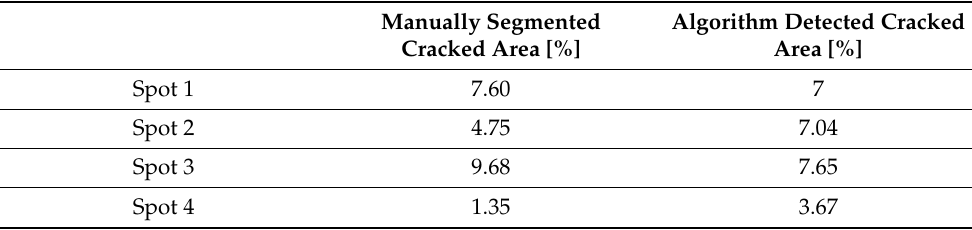
Table 4. Percentage of pavement surface affected by the cracks identified with the algorithm and based on the manually segmented